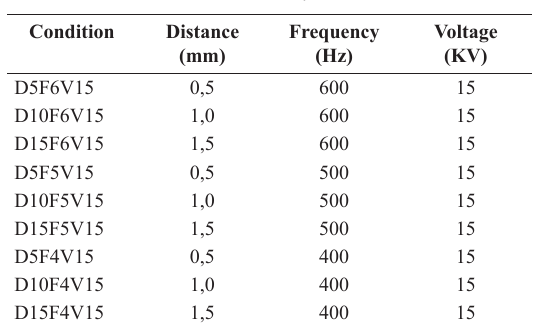
Figure 1. DBD reactor design Table 1. Parameters used in this study.